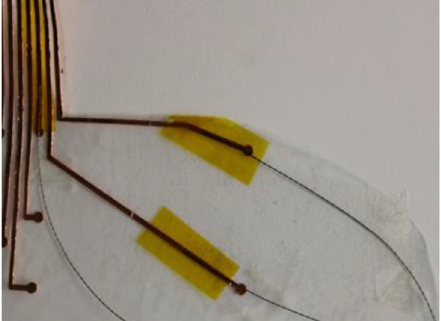
Figure 4. Through holes in the sensor pad for the conductive thread to join with the route layer. The thread fed through the hole is secured with conductive tape to ensure contact with the sensor pads (Figures 5 and 6).